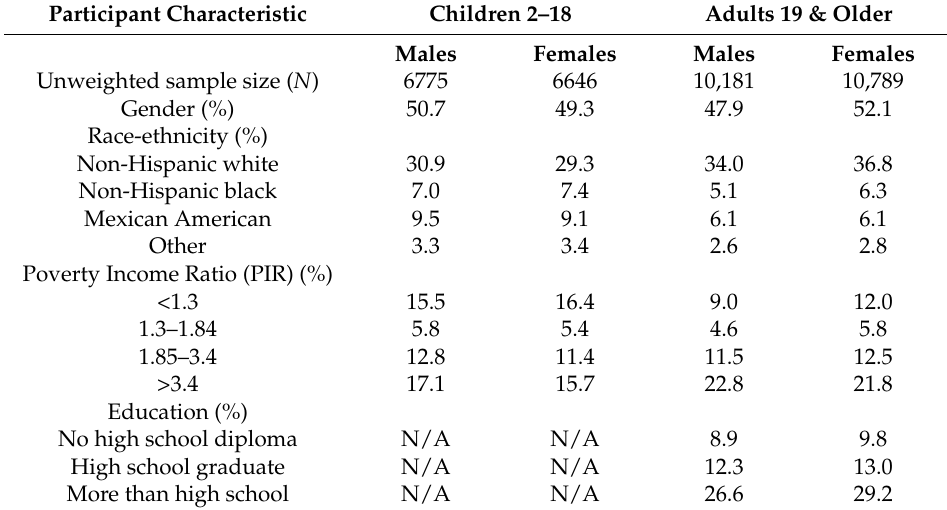
Table 1. Characteristics of study population, 2003–2010.